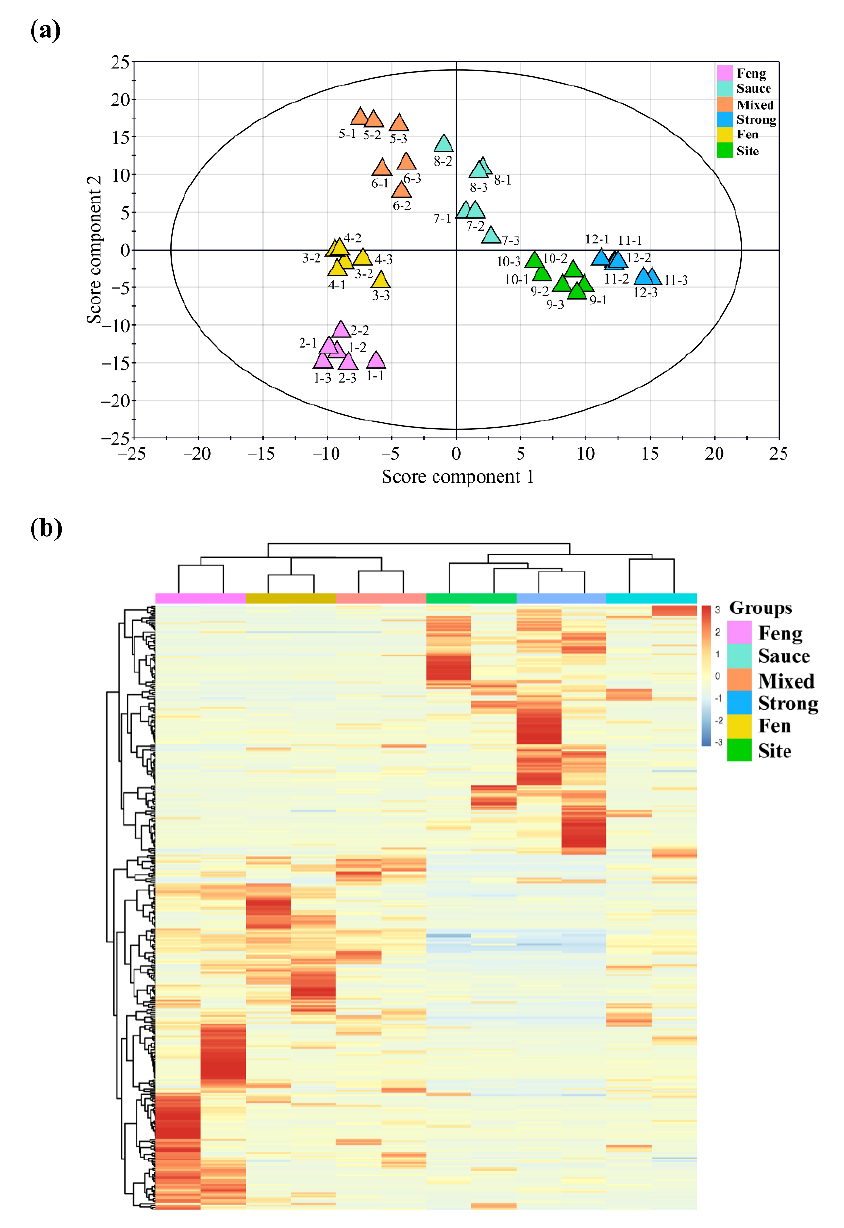
Figure 4. Multivariate statistical analysis of different flavoring types of Chinese liquors. ( a ) PLS score scatter plot of the different flavor liquors based on a correlation analysis. Ellipses and shapes show clustering of the samples. The plot shows a strong correlation between the various flavor liquors. ( b ) Hierarchical clustering heat map of twelve Chinese liquors, with the degree of 339 compounds change in the six different flavoring type liquors. Individual samples (horizontal axis) and compounds (vertical axis) are separated and the top dendrogram is scaled to represent the distance between each branch. Different bar colors represent six types of flavor liquors.